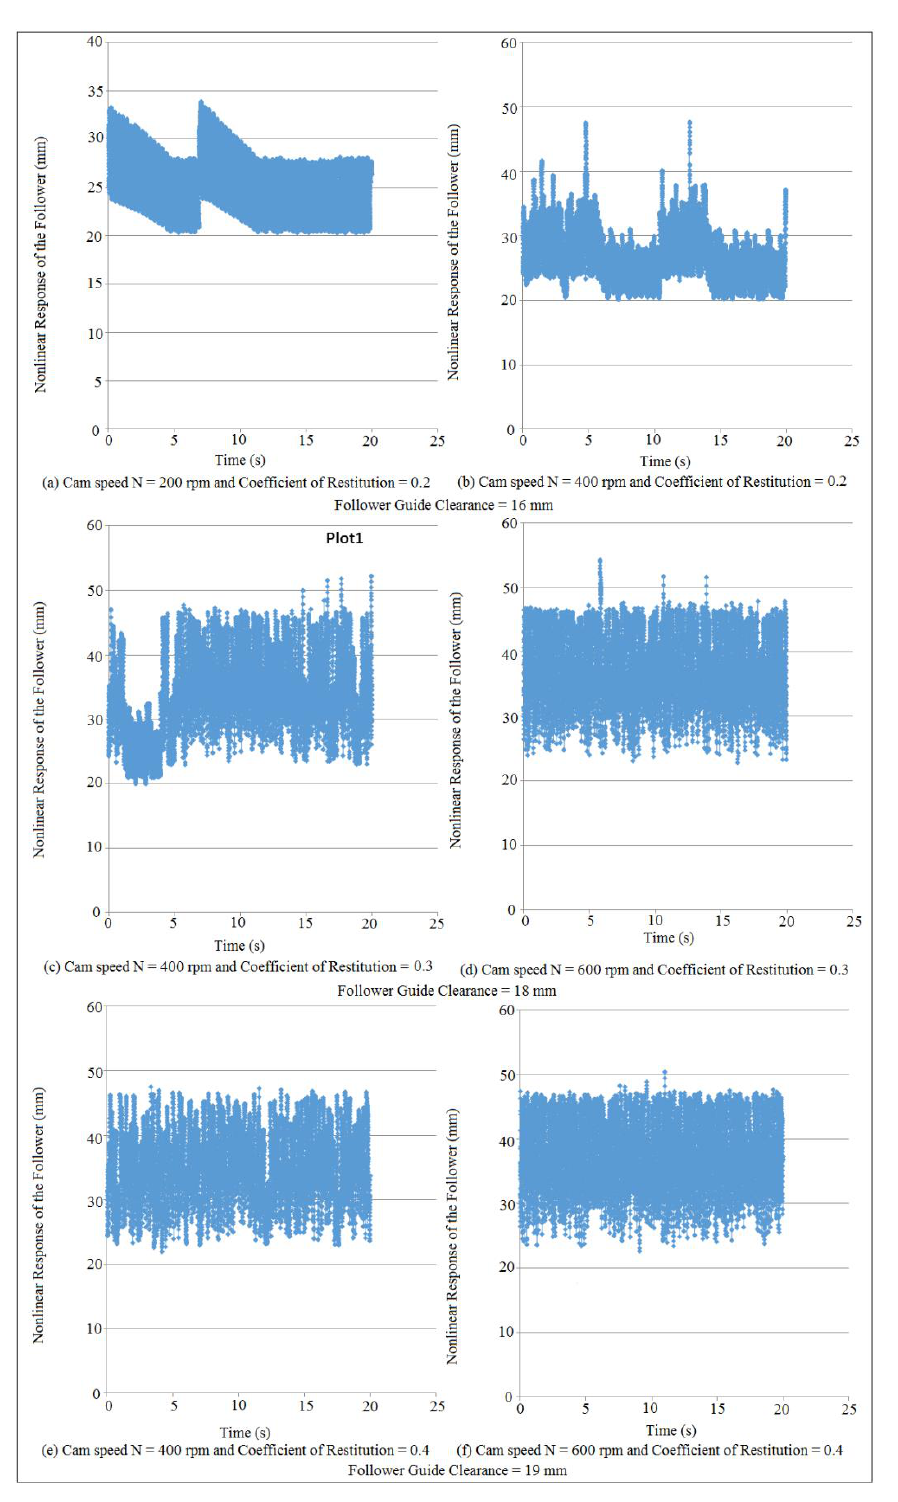
Figure 5. Nonlinear response mapping when the follower offsets to the left (O = 10 mm). Figure 6 shows the nonlinear response when the follower offsets to the right at (e = 10, 20, 30 mm) for follower guide’s clearance (16 mm) and cam speeds (N = 200 rpm) with impact coefficient of restitution (0.2). The peak of rise and return strokes is increased with the increase of follower’s offset which settles down after the second cycle of cam rotation. The follower lost an intangible potential energy due to sliding since the contact between